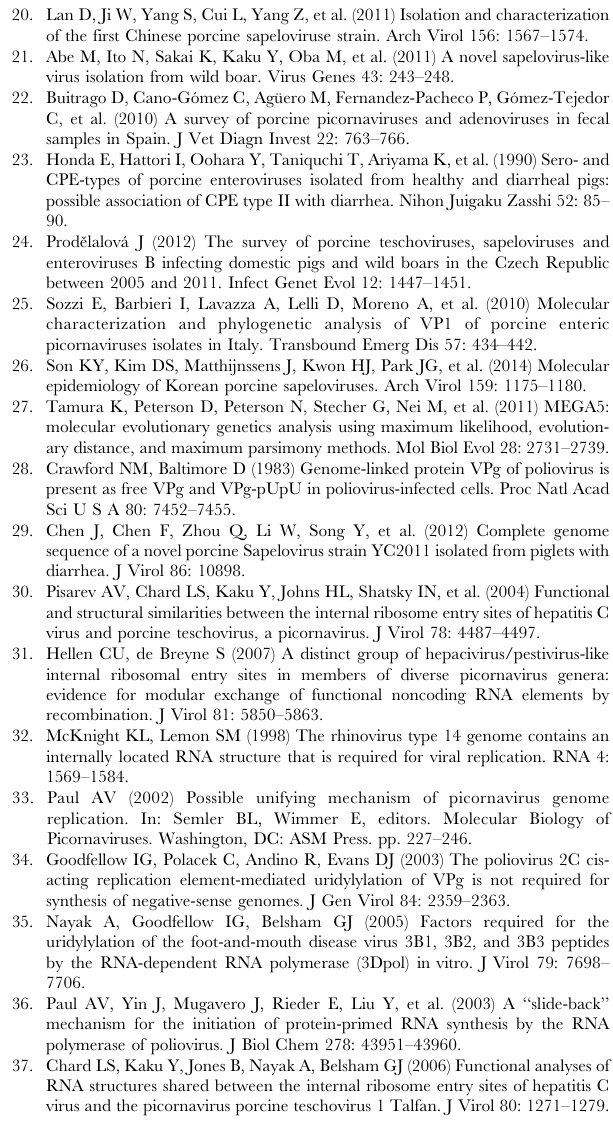
File S1 Supplementary Tables. Table S1. Oligonucleotide primers for amplifying and sequencing of porcine sapelovirus strains. Table S2. Strains of picornaviruses and their GenBank accession numbers used in this study. Table S3. The length of 5 9 untranslated region, each part of the open reading frame, 3 9 untranslated region and the complete genome excepting the poly(A) tail. Table S4. Comparison of nucleotide/deduced amino acid sequences between the porcine sapelovirus